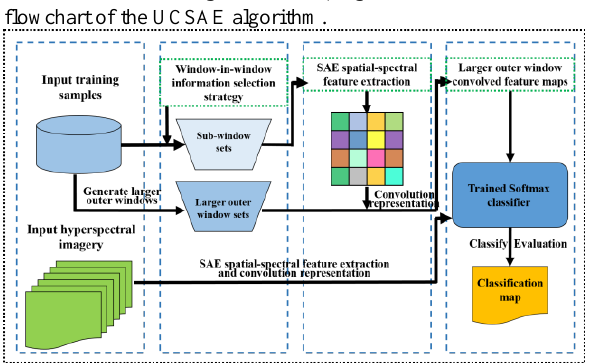
Figure 2 The flowchart of